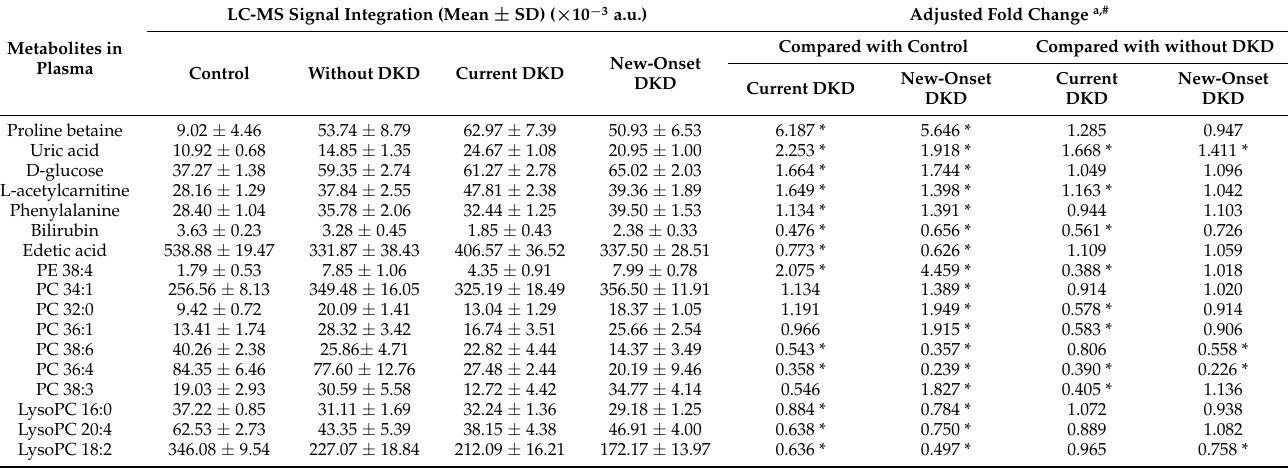
Table 3. Altered metabolites in the plasma samples of the type 2 diabetic patients with DKD, compared to the patients without DKD or the control participants.